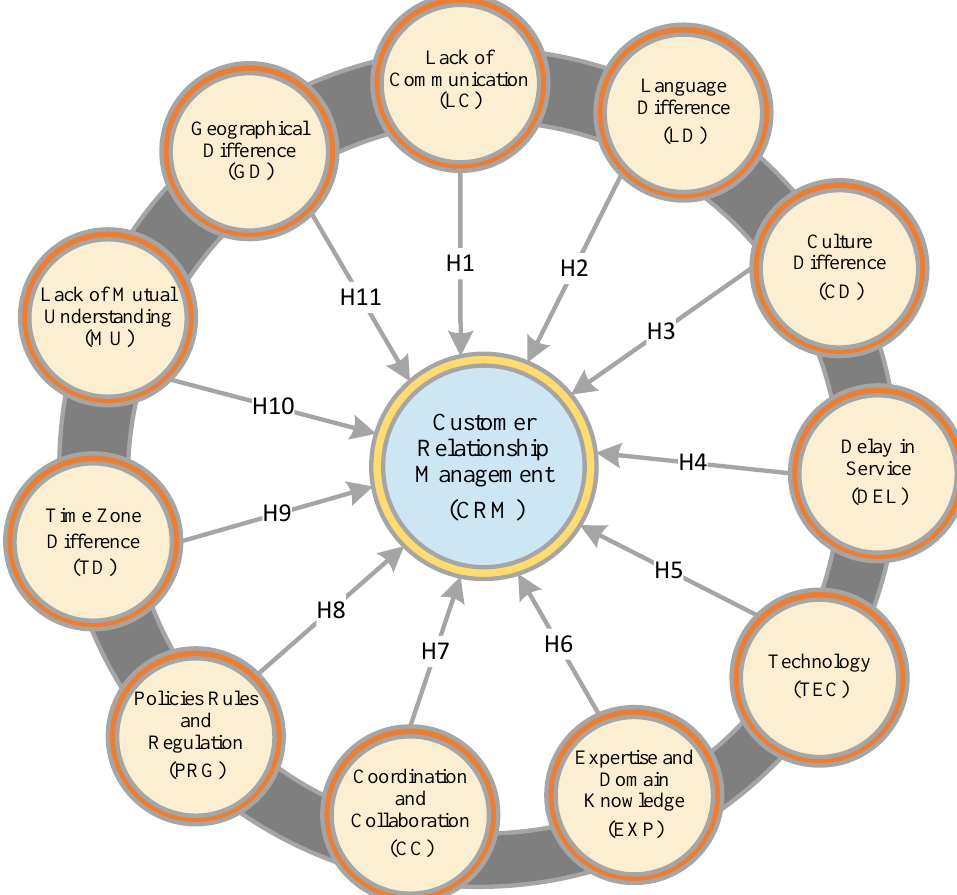
Figure 4. Proposed Conceptual Framework for